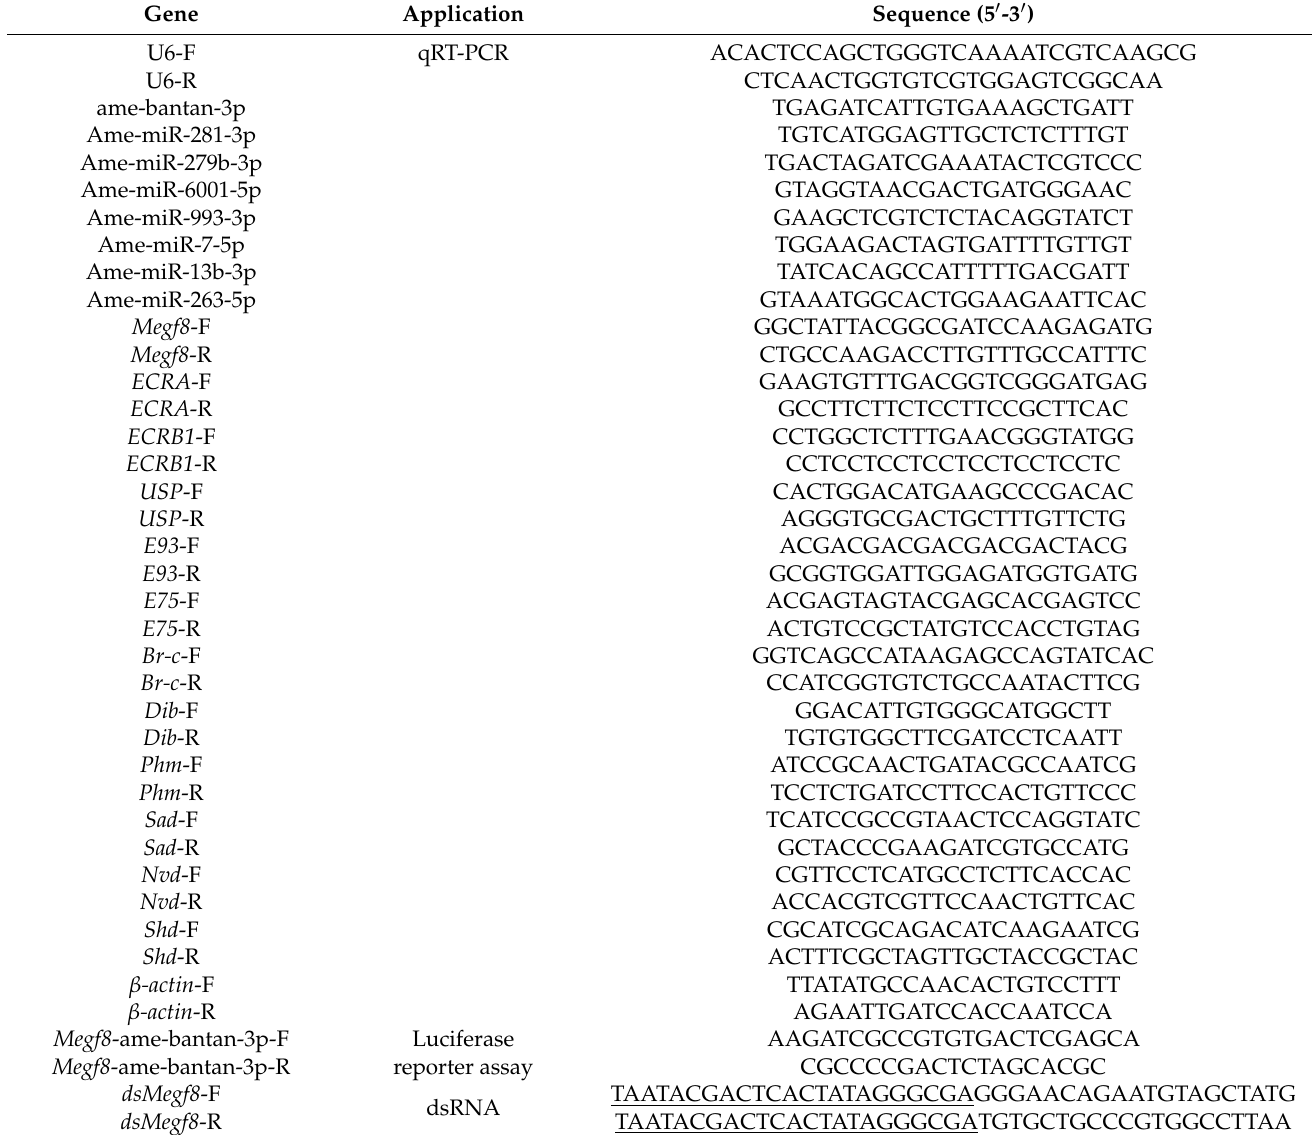
Table 3. The primer sequences used for qPCR and construction of luciferase reporter